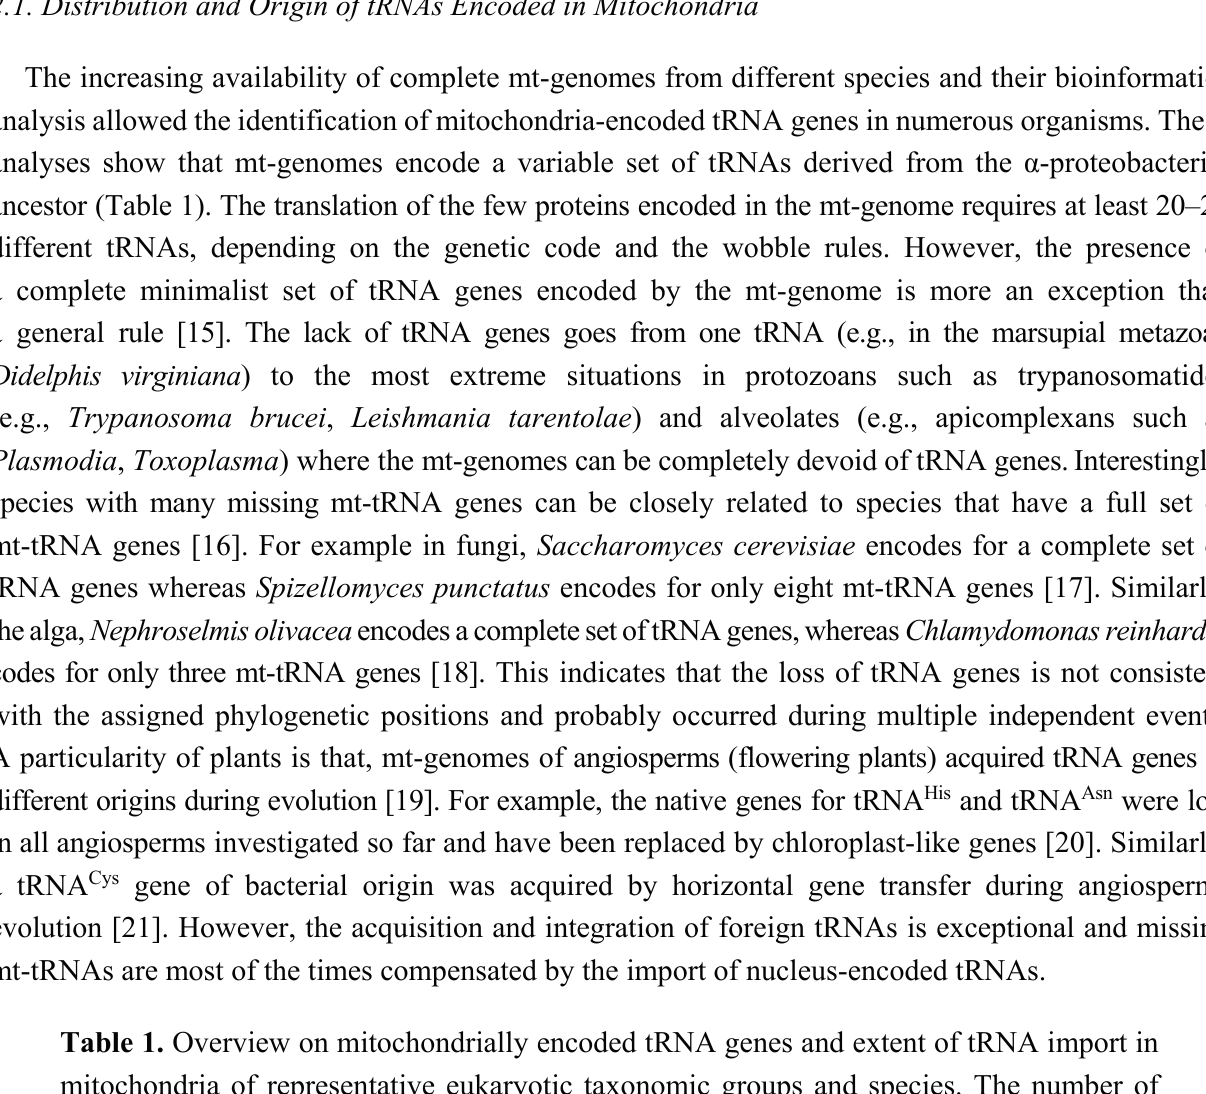
Table 1. Overview on mitochondrially encoded tRNA genes and extent of tRNA import in mitochondria of representative eukaryotic taxonomic groups and species. The number of tRNA genes encoded by the mt-genome that are indicated, including duplicated genes. Genbank accessions and references that allowed numbers determination are